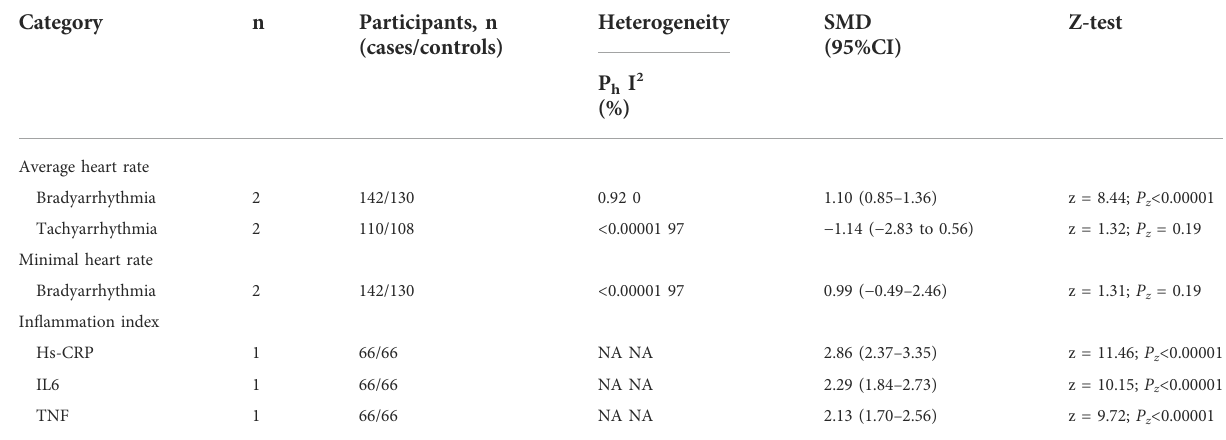
TABLE 2 Meta-analysis of arrhythmia patients ’ treatment with